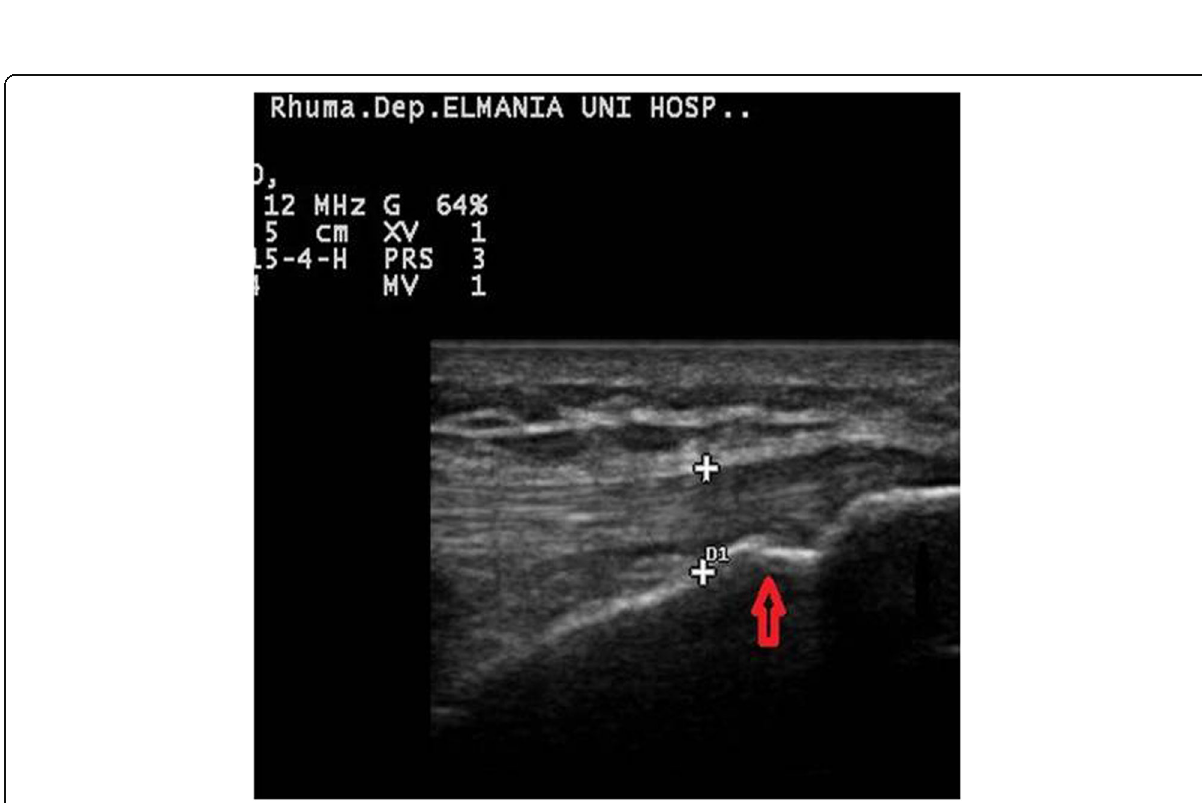
Fig. 8 MSUS of right distal patellar tendon of 41 years male RA patient showing abnormal structure, increased thickness (5.7 mm), and erosion (red